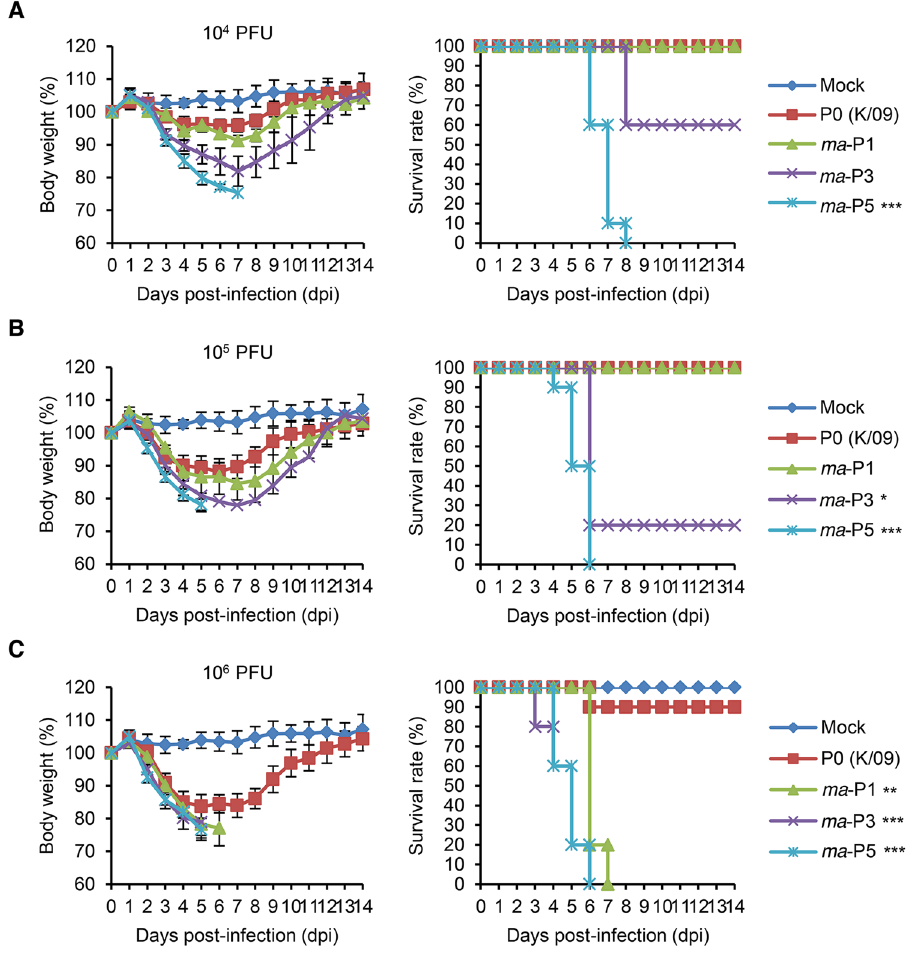
Figure 1. Pathogenicity of the K/09 and its mouse-adapted viruses in mice. Averaged body weight changes and survival rates of BALB/c mice (n = 10 per group) after the intranasal infection (10 4 , 10 5 , and 10 6 PFU) with the wild-type K/09 (P0) and its mouse-adapted ( ma -P1, -P3, and -P5) viruses were represented in average. Mice in the mock group were infected with PBS. Error bars denote standard deviation (SD). * P < 0.05, ** P < 0.01, and *** P < 0.001 (compared with the K/09 infection